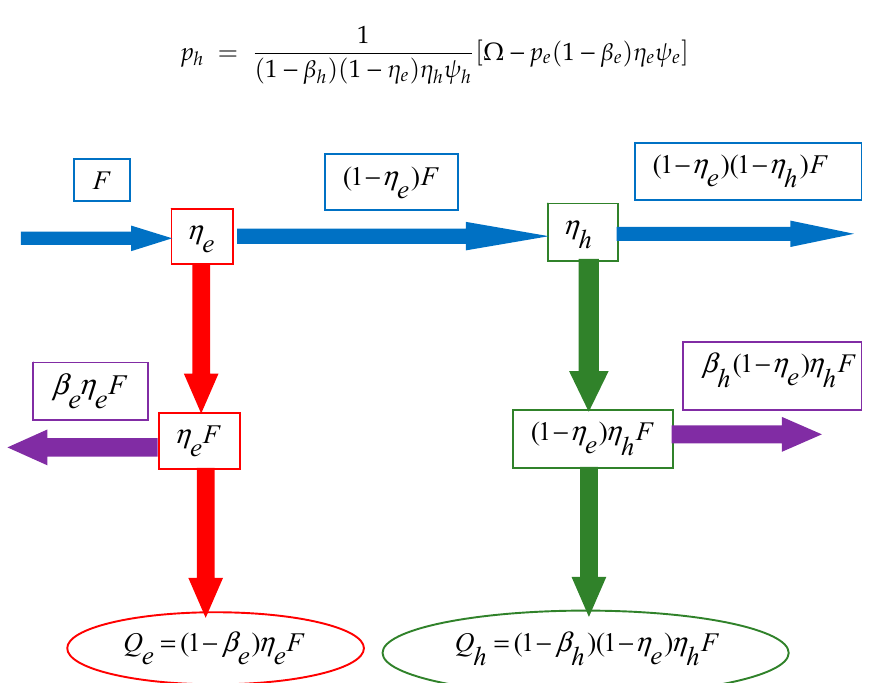
Figure 2. The scheme of energy flows. F is fuel, η is efficiency, β is losses (or energy consumption for